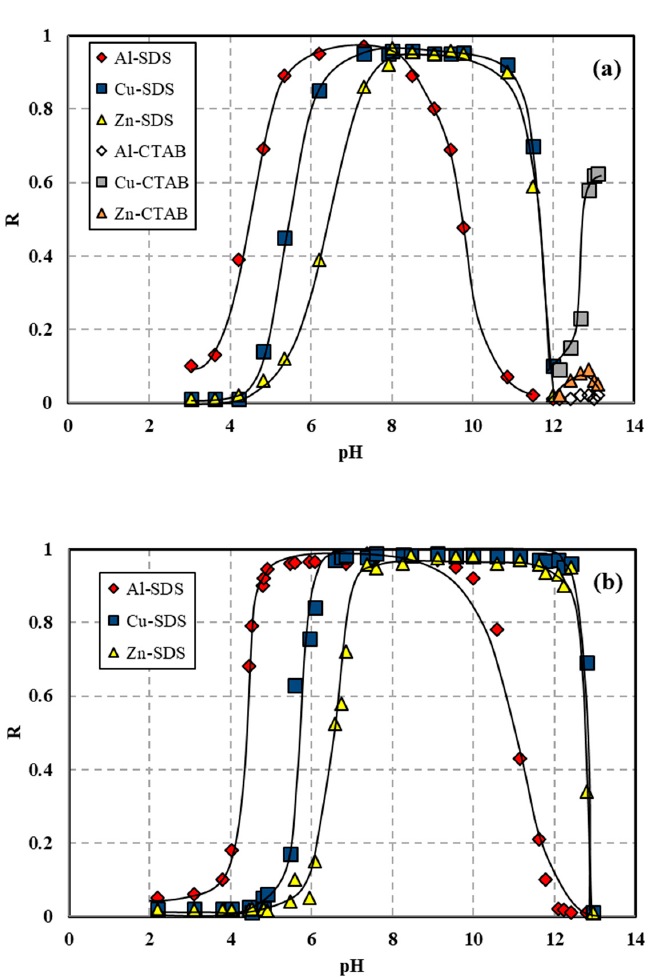
Figure 2. Influence of the pH of initial solution on the final removal efficiency of Al(III), Cu(II) and Zn(II) flotation: ( a ) c 0(Al) = c 0(Cu) = c 0(Zn) = 0.15 mmol dm − 3 , c SDS = 0.125 mmol dm − 3 , c CTAB = 0.165 mmol dm − 3 ; ( b ) c 0(Al) = c 0(Cu) = c 0(Zn) = 2 mmol dm − 3 , c SDS = 0.187 mmol dm − 3 .